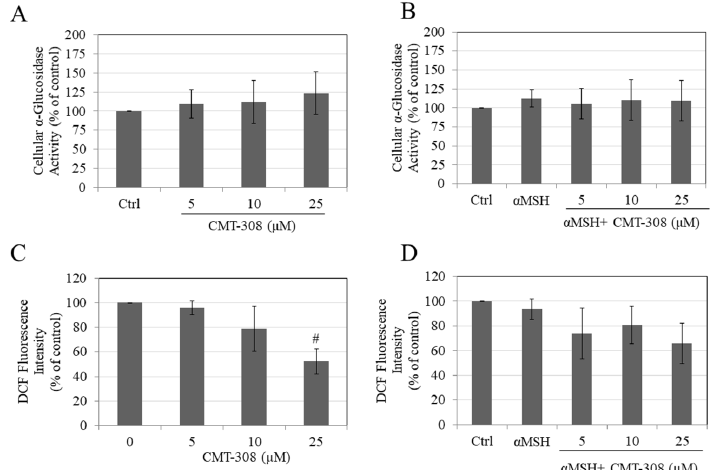
Figure 4. Intracellular α -glucosidase activity in B16F10 cells under ( A ) basal and ( B ) α -MSH- stimulated conditions; intracellular ROS generation measured by DCF fluorescence intensity under ( C ) basal and ( D ) α MSH stimulated conditions, # p < 0.01 vs. Ctrl; all data are mean ± SD of at least two independent